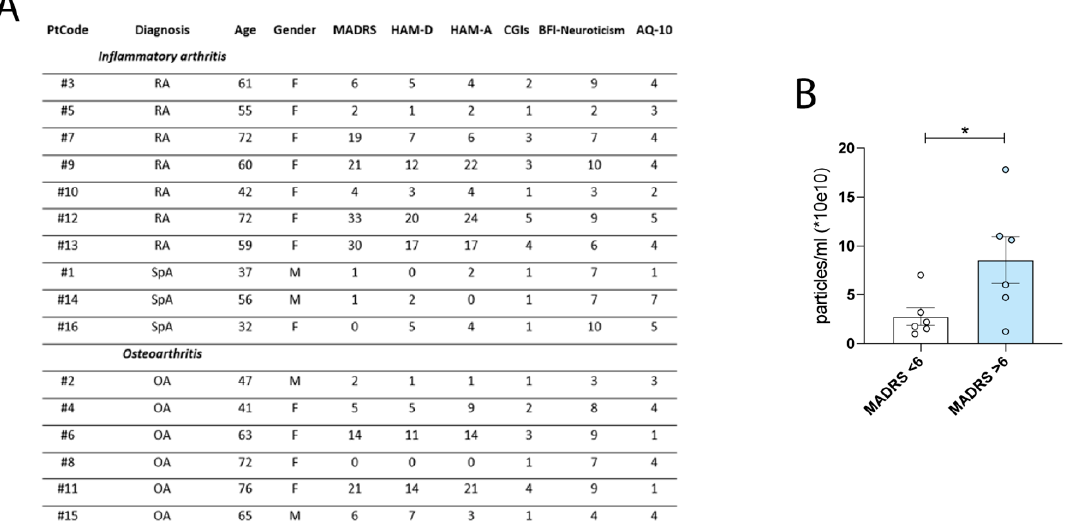
Figure 5. Mood disorder severity and EVs levels in human synovial fluids. ( A ) Table summarizing age, gender, and psychiatric scales (MADRS, HAM-D, HAM-A, CGI, BFI-Neuroticism, and AQ-10) for each RA and OA patient. 37.5% of the total patients report at least mild psychiatric symptoms, mild anxiety, and depressive symptoms. AQ-10: 10-item Autism Spectrum Quotient; BFI: 10-item Big Five Inventory, Neuroticism is calculated as the sum of item 4 and 9; CGIs: Clinical Global Impression-Severity of Illness; HAM-A: Hamilton Anxiety Rating Scale; HAM-D: Hamilton Depression Rating Scale; MADRS: Montgomery Asberg Depression Rating Scale; OA: osteoarthritis; RA: rheumatoid arthritis; SpA: spondyloarthritis. ( B ) EVs concentration is higher in patients presenting mild and moderate depressive symptoms (MADRS > 6; Unpaired t -test, * p < 0.05).